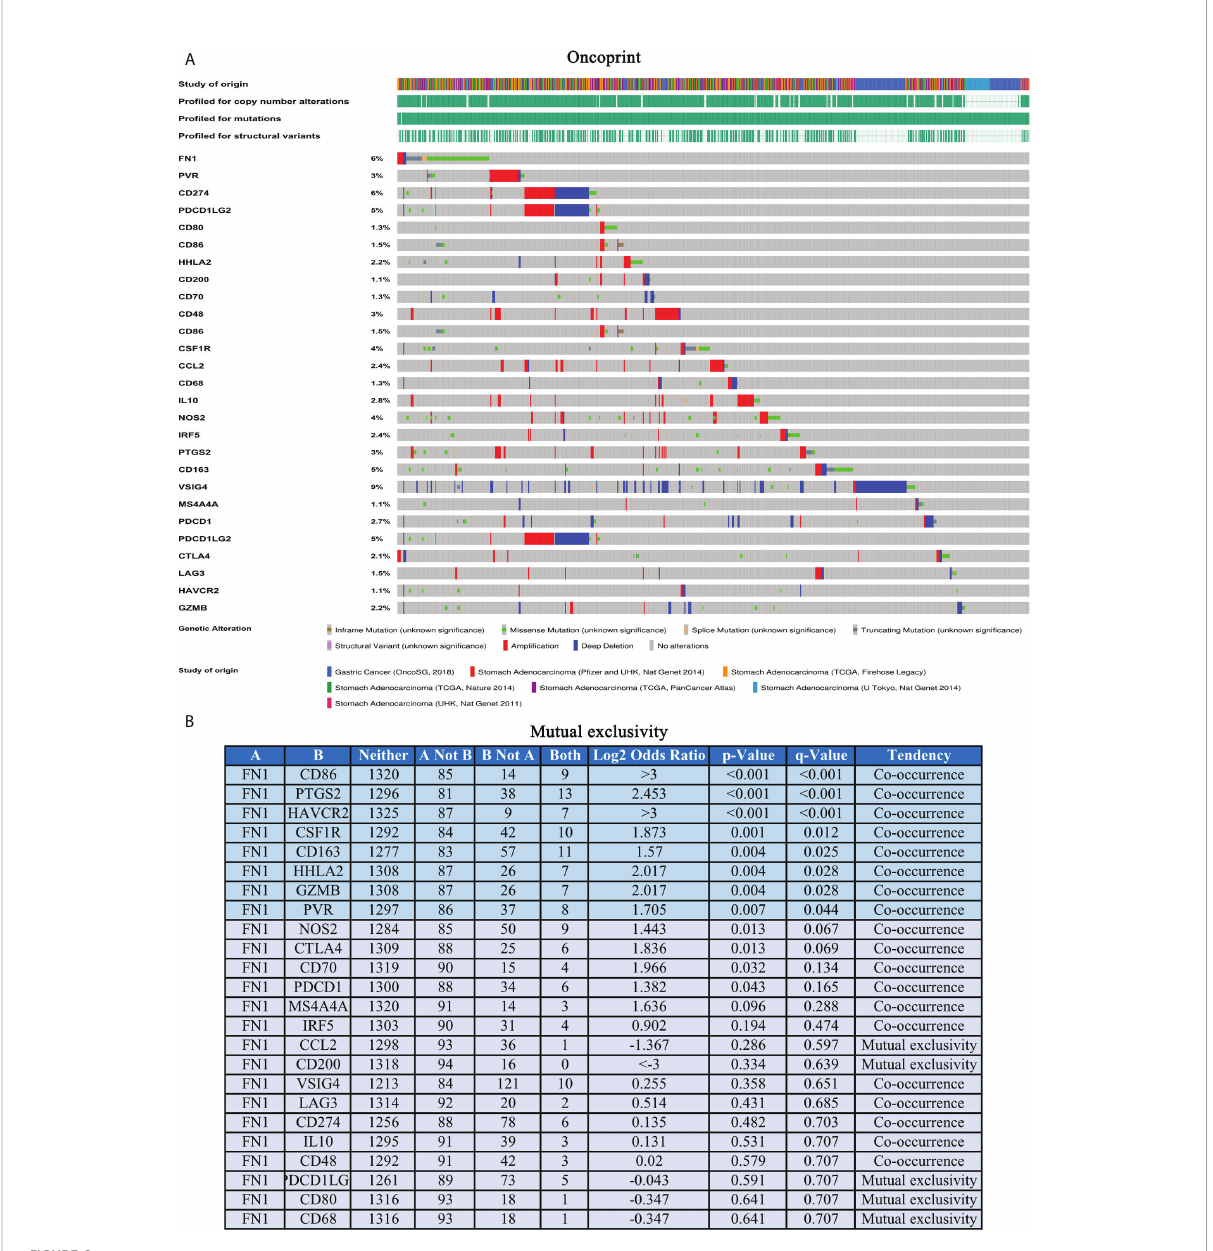
FIGURE 6 FN1 with immune checkpoints and gene markers of macrophages in STAD. (A) Landscape of FN1 and immune checkpoint alteration and gene markers of macrophages in STAD. (B) Mutual-exclusivity analysis between FN1 and multiple-immune checkpoints and gene markers of macrophage in STAD. The altered relationship between FN1 and each immune checkpoint and gene marker of macrophage. The detailed log2 odds ratio, p-value, Q-value, tendency, and signi fi cance were individually presented in each panel. Q-value <0.05 was considered to be statistically signi fi cant (indicated as yes, and others as